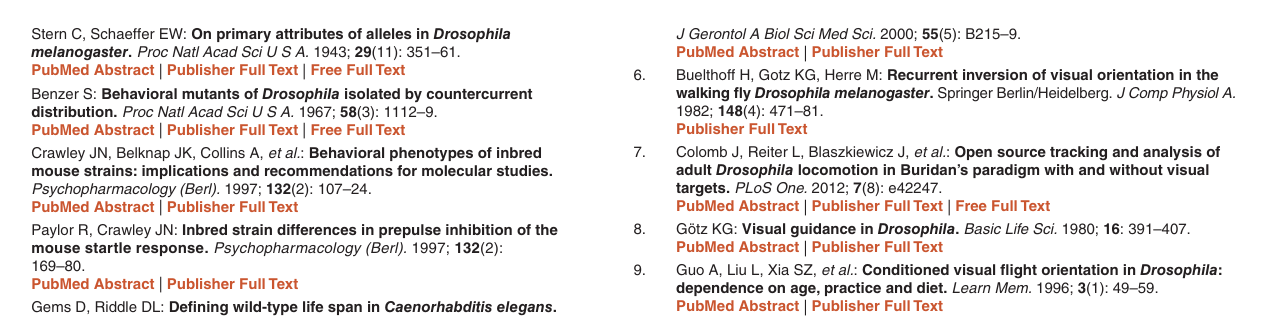
figshare: Buridan raw data: Sub-strains of Drosophila Canton-S differ markedly in their locomotor behaviour, doi: 10.6084/m9. figshare.1014264 16 Additional data can be downloaded from Figure